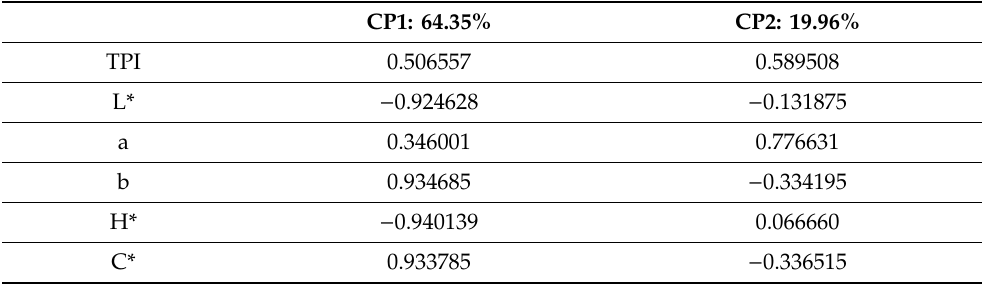
Table 5. Principal components analysis. Factor loadings of the first two components